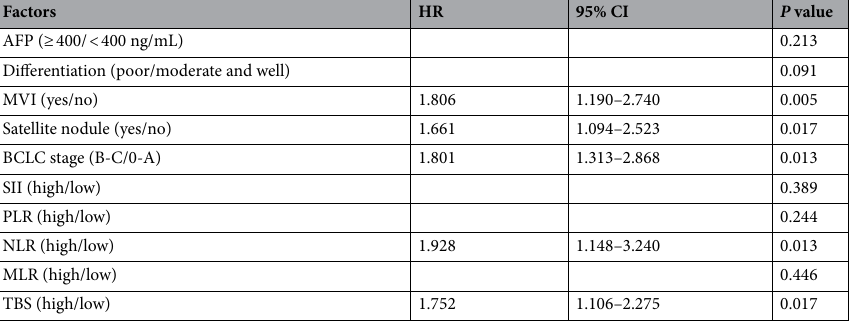
Table 4. Multivariate analyses for RFS. AFP alpha-fetoprotein, MVI microvascular invasion, BCLC Barcelona Clinic Liver Cancer, MLR monocyte to lymphocyte ratio, PLR platelet-to-lymphocyte ratio, SII systemic immune-inflammation index, NLR neutrophil to lymphocyte ratio, TBS tumor burden